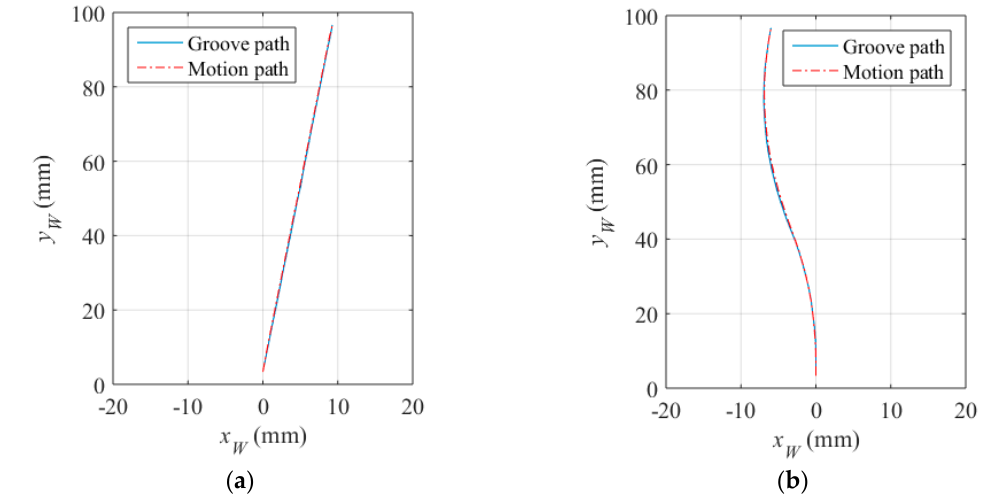
Figure 26. Comparison between the groove path detected and the motion path of the workpiece. ( a ) The straight line path; ( b ) The S-curve path.